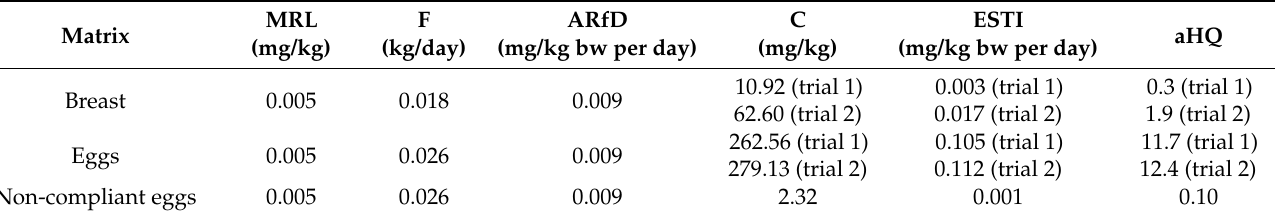
Table 6. Acute dietary Risk assessment